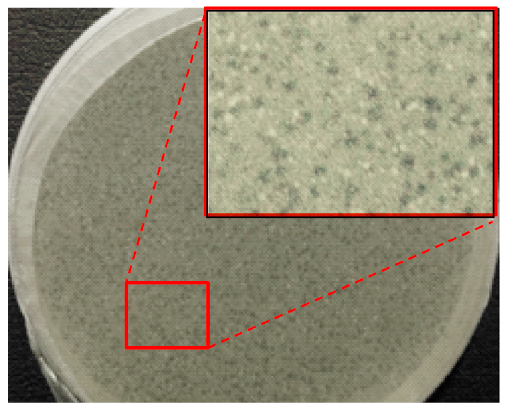
Figure 4. Overlayer agar plate of a preparation of Fersis and enlargement.